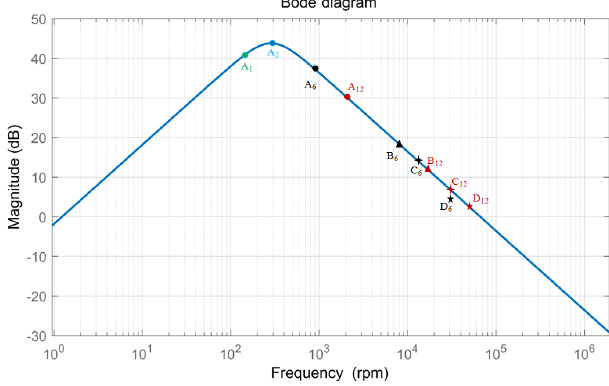
Figure 3. Bode magnitude plot of the S ( s ) for the DDFS.